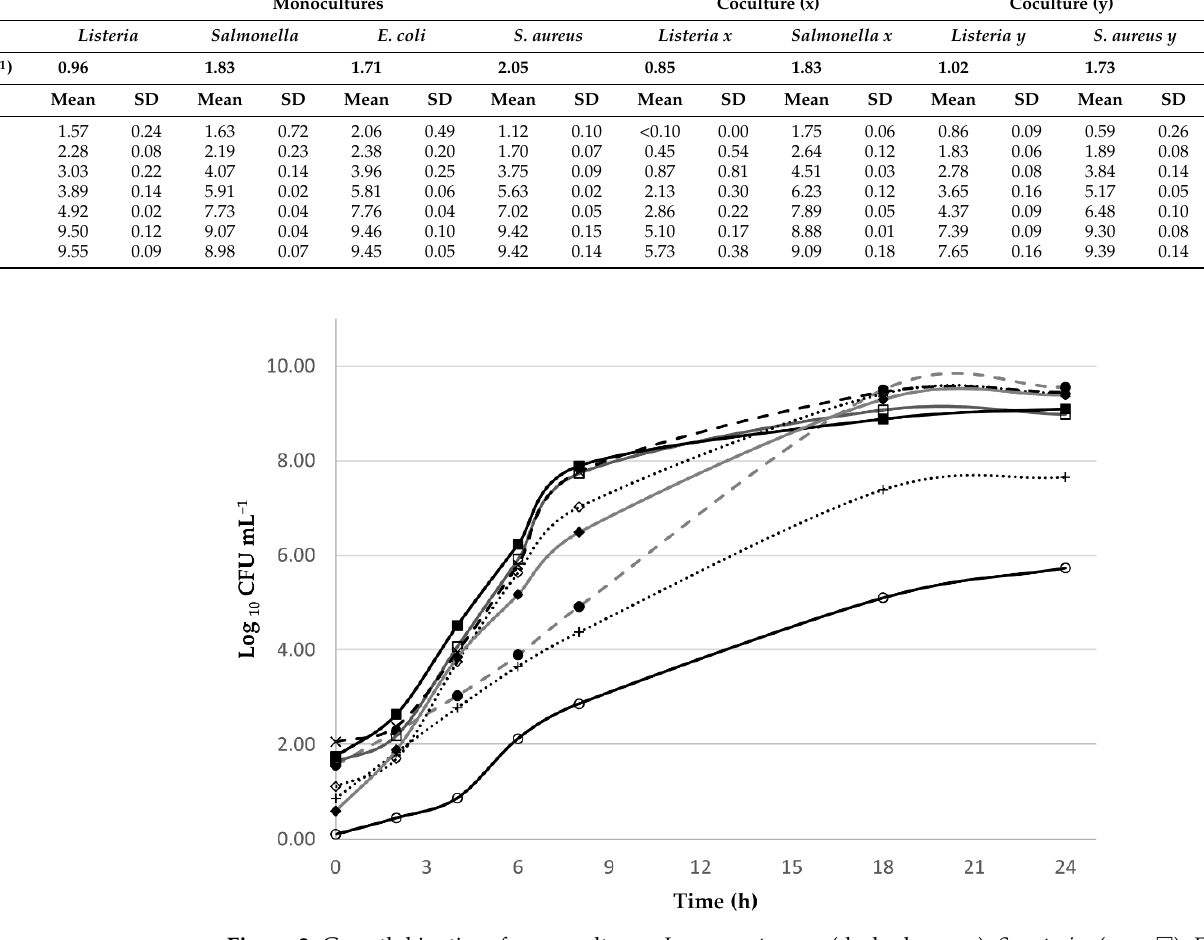
), S. enterica (cid:35)